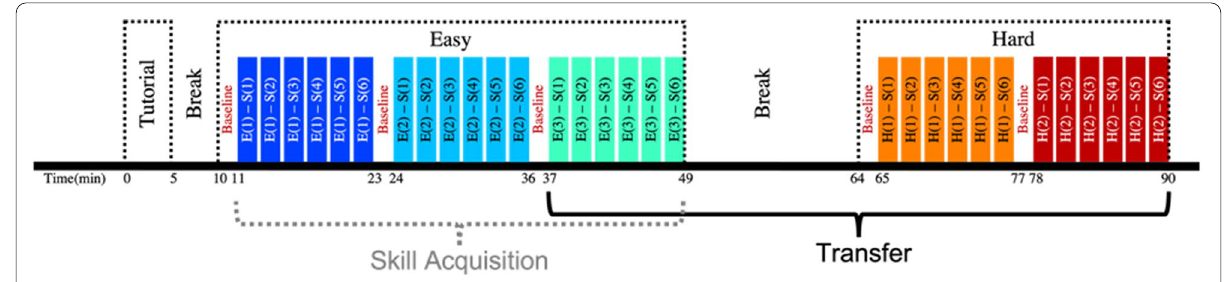
Fig. 3 Experimental protocol began with a tutorial session followed by easy and hard sessions, respectively. Easy sessions consisted of three similar scenarios that occurred at 11:00 AM (simulator time) and were randomly administered. Hard sessions consisted of two different scenarios that occurred at 8:00 PM or 6:00 AM and were also randomly administered. Each scenario was approximately 12 min long and consisted of six subareas that each lasted 2 min. Within each of these subareas’ participants were required to scan the assigned area and find the